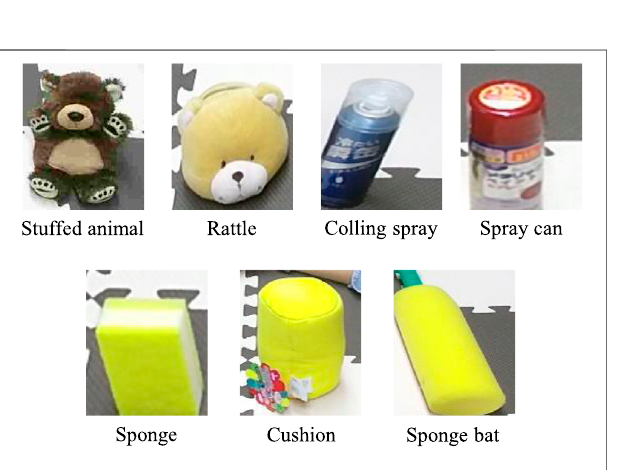
FIGURE 11 | Examples of objects in categories that were misclassi fi ed many